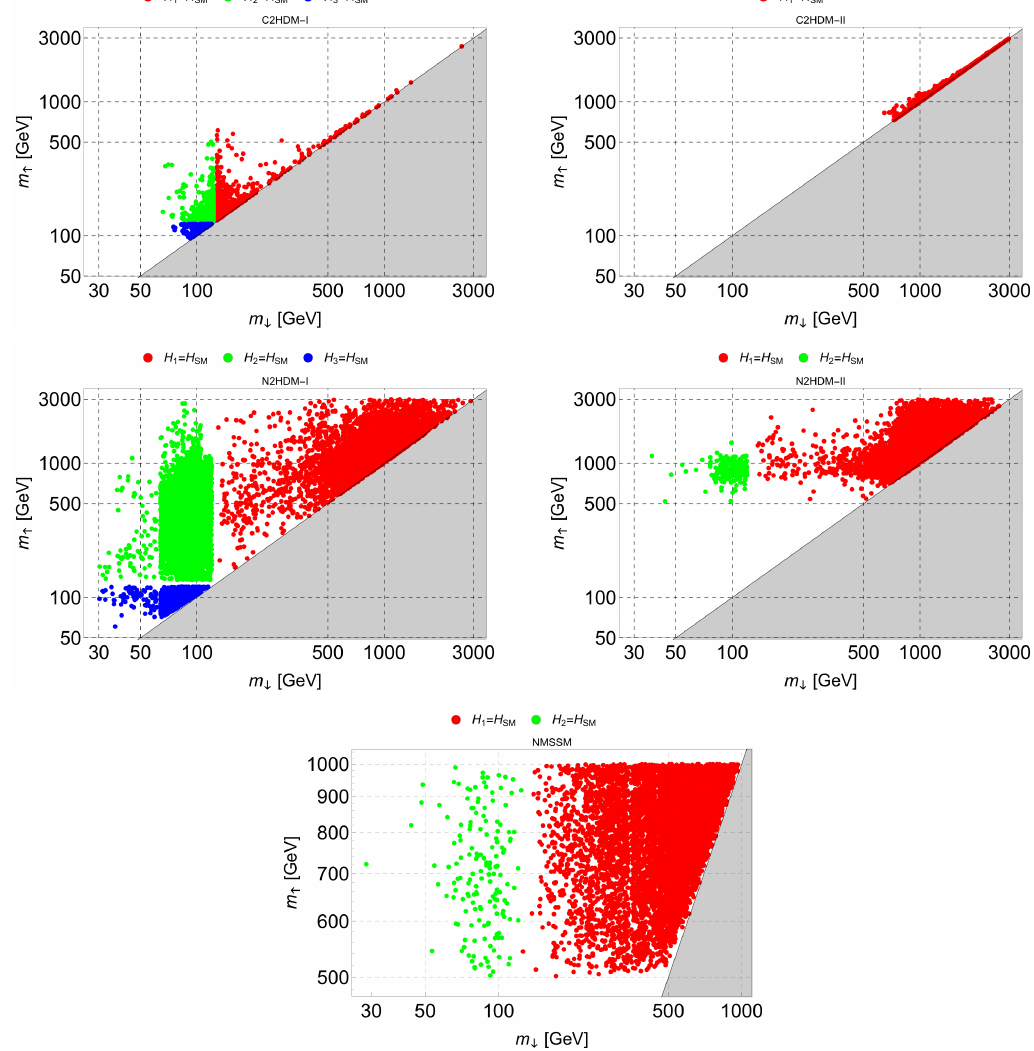
Figure 5 . Mass distributions of the non-SM-like neutral Higgs bosons in the C2HDM-I and II (upper left and right), the N2HDM-I and II (middle left and right), and the NMSSM (lower) for the parameter points respecting all applied constraints. The colour of the points denotes which Higgs boson is SM-like. In the shaded region m ↑ ≤ m ↓